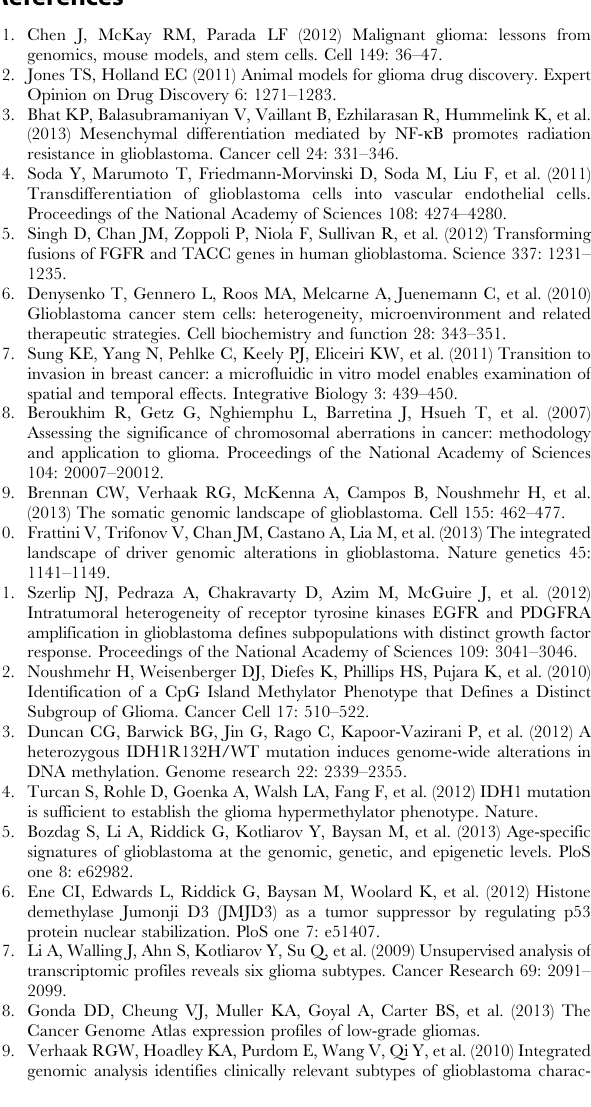
Figure S7 PRMT5 expression for matched PT, in vitro, in vivo and ex vivo samples. Each column represents a matched samples and y-axis is the PRMT5 expression value. Table S1 List of differentially methylated and differen- tially expressed